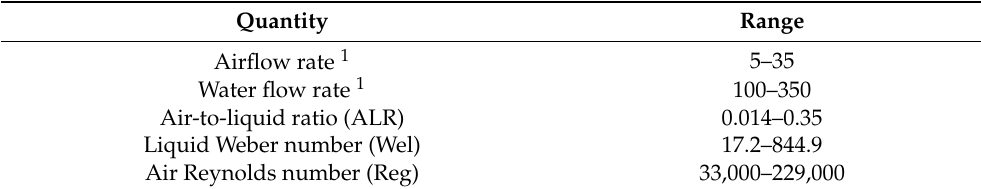
Table 1. The range of operating conditions and representative dimensionless